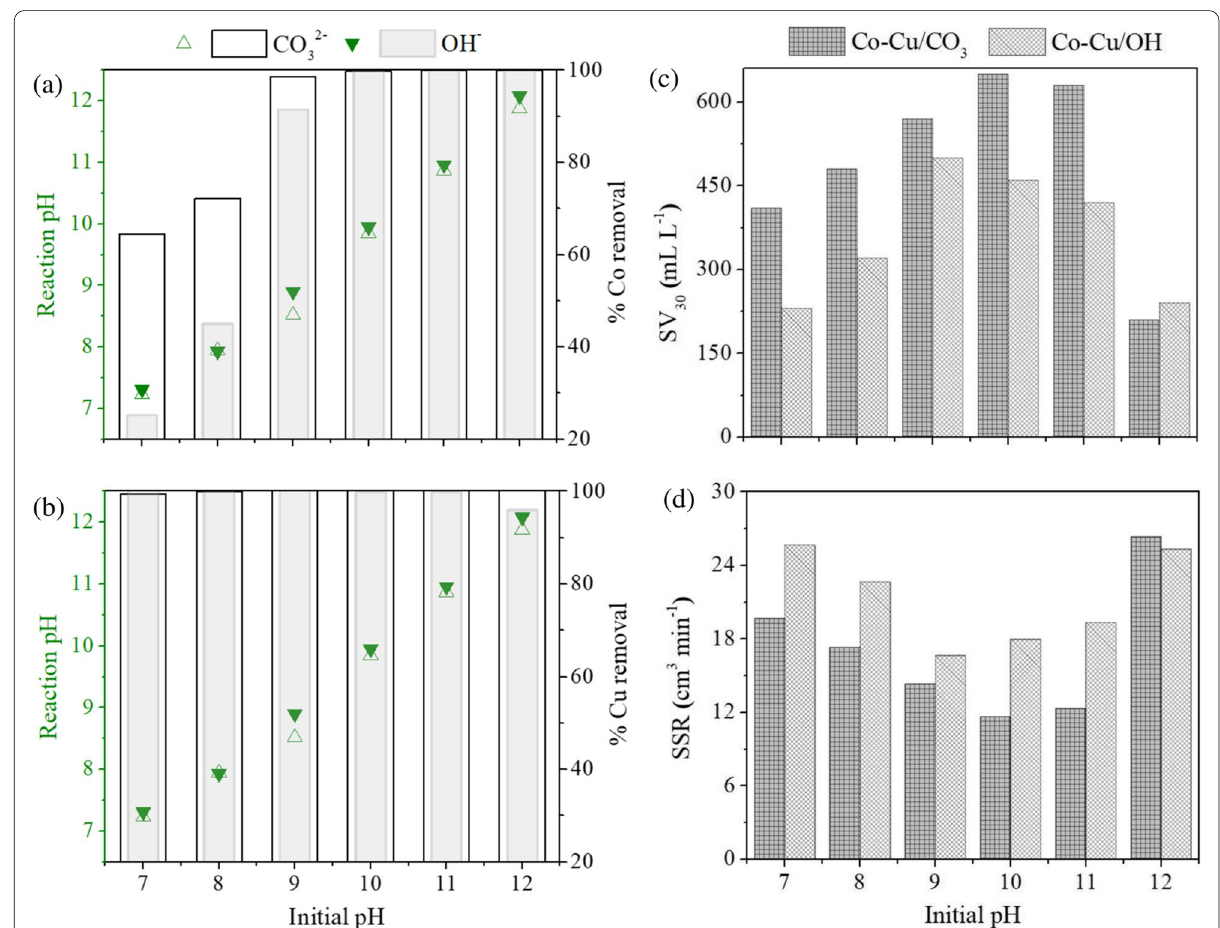
Fig. 8 Removal efficiency of ( a ) cobalt and ( b ) copper, ( c ) sludge volume at 30 min and ( d ) sludge settling rate in the co‑contaminated system at different pH values using different